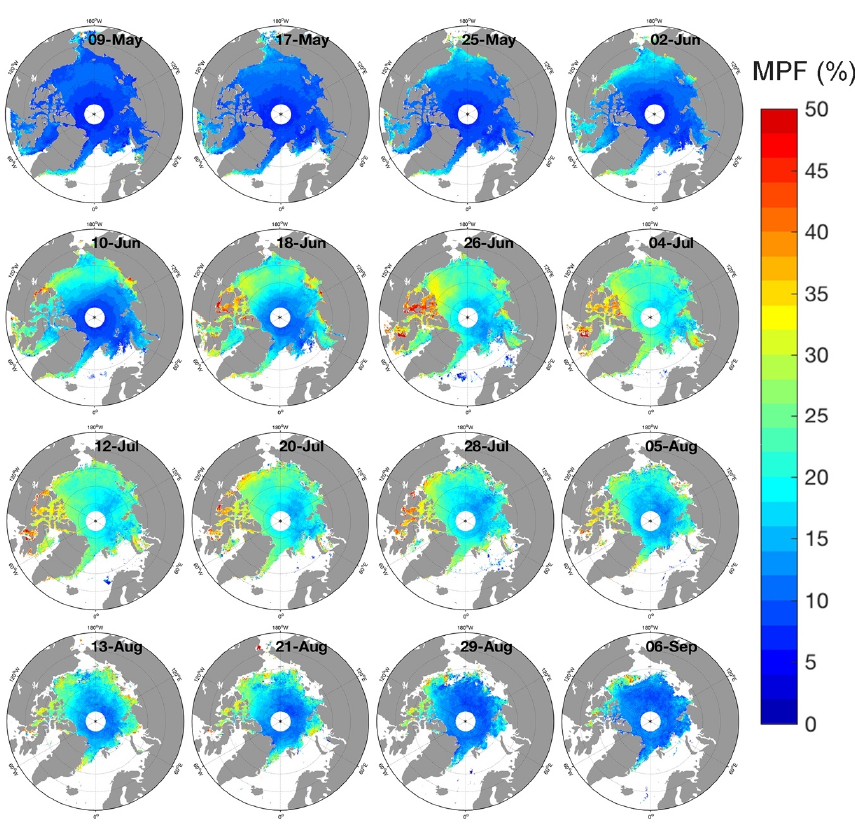
Figure 13. Same as Figure 12, except for the UH_MPFv2.